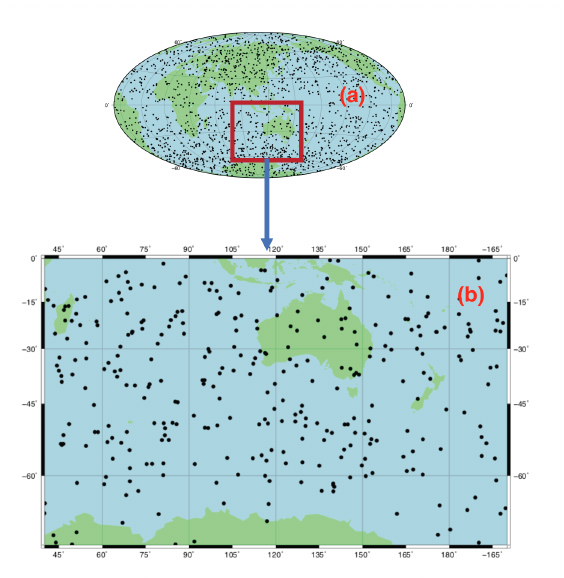
Figure 10. Distribution of the IRO data from COSMIC ionospheric occultation events on 1 January 2009. ( a ) all over the globe. ( b ) in the Australian region.